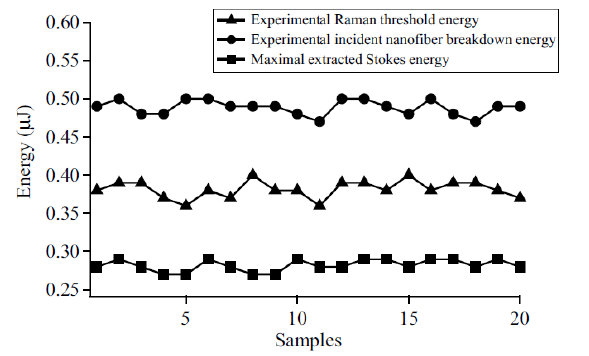
Fig. 2. Experimental Raman threshold and breakdown energies, extracted Stokes energy of 20 samples of nanofibers with a radius of 300 nm.